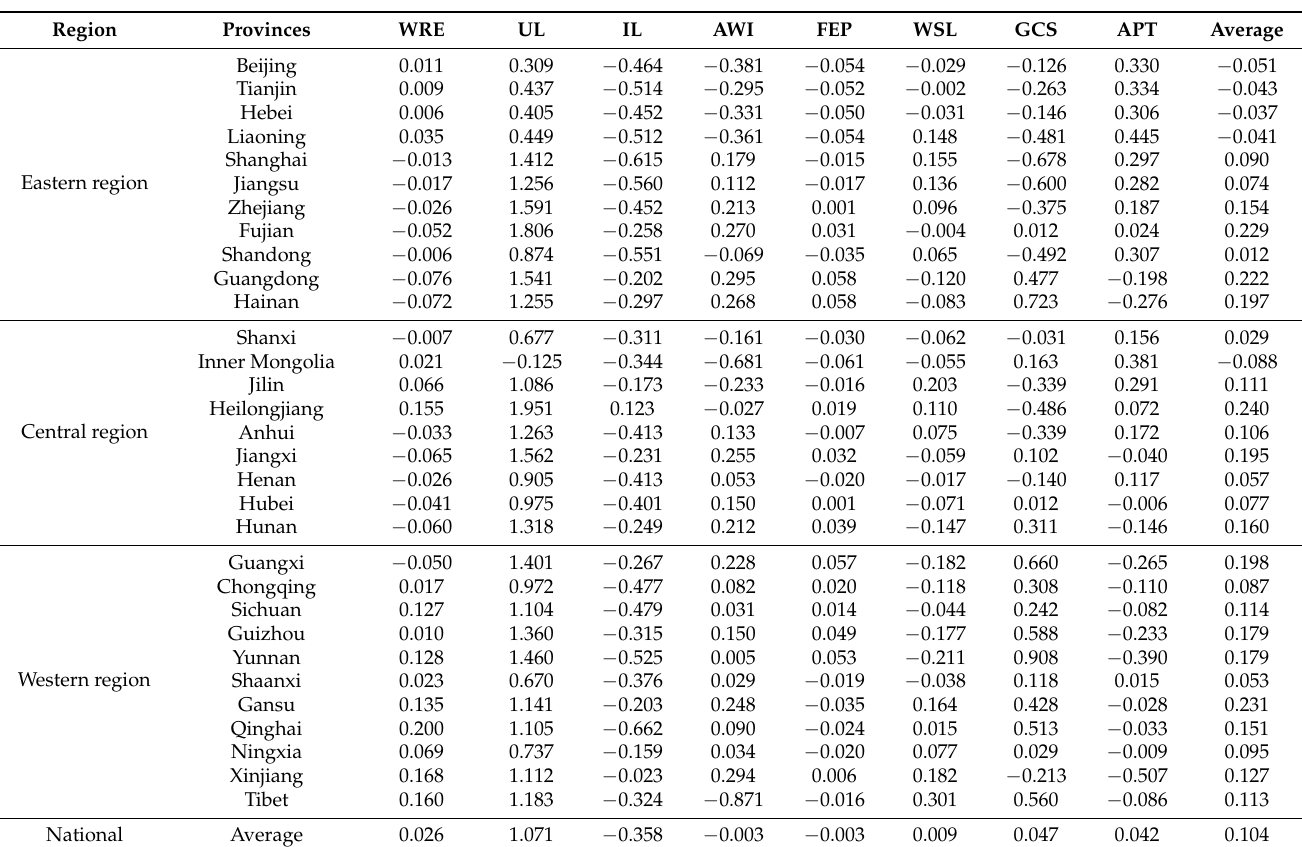
Table 6. Parameter estimates of influencing factors of agricultural water use green efficiency in